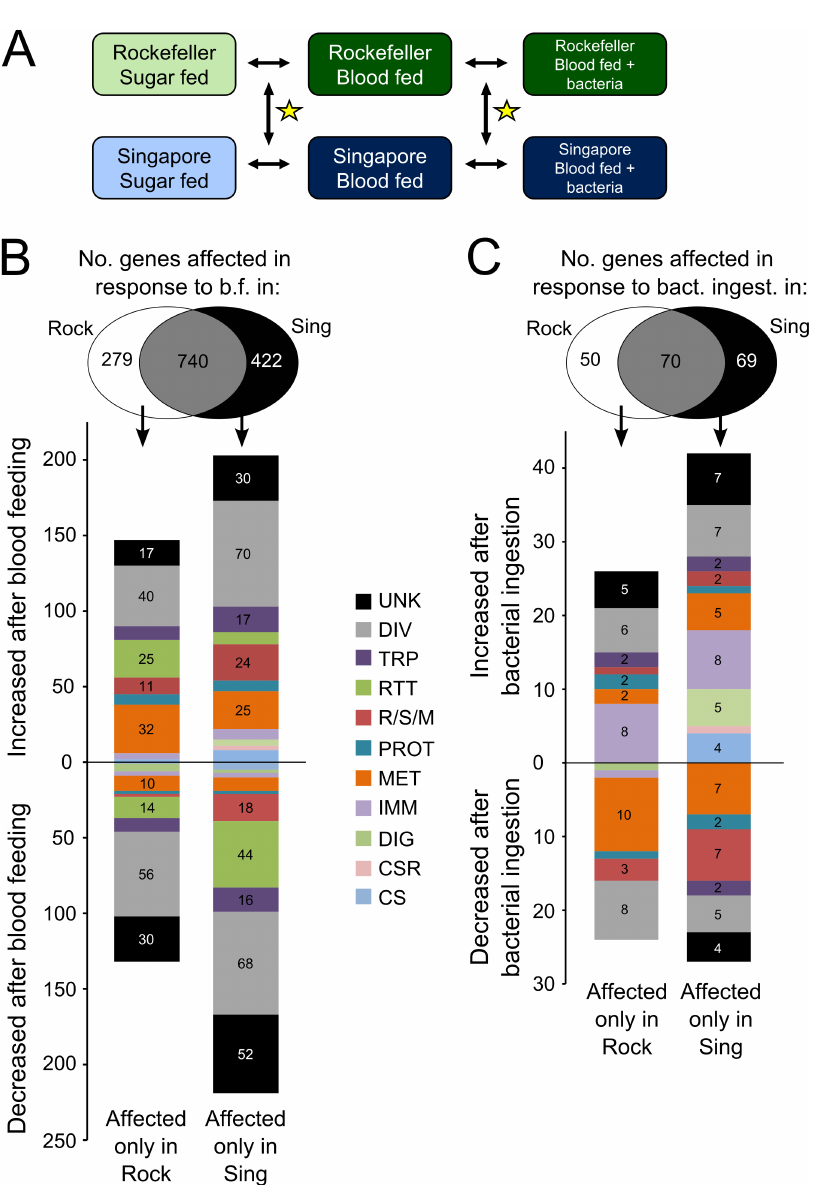
Fig 5. Genes showing significant changes in transcript abundance in response to blood feeding or bacterial re-introduction in either Rockefeller or Singapore female midguts. (A) Experimental design to measuregene expression differences between Rockefeller and Singapore female midguts. Rockefeller and Singaporefemales were reared in paralleland providedwith 3% sucrose + antibiotics (pen/ strep + gent) upon eclosion.At 5–7 days post eclosion,females were maintained on sucrose, given a sterile blood meal, or given a blood meal spiked with a mixed culture of seven common mosquitomidgut bacteria(S2 Table). Midguts were dissected from each strain/feeding treatment 12 hours post blood feedingand genome wide gene expressionwas measuredfor each strain/feeding treatment relative to a pooledreference sample using custom Agilent gene expressionmicroarrays. Comparisons of interest in this experiment (indicated by black arrows) are as follows: Rock sucrose vs. Rock blood fed, Sing sucrose vs. Sing bloodfed, Rock blood fed vs. Rock bacteria fed, Sing blood fed vs. Sing bacteriafed. We were also interested in how responseto treatment differed betweenthe strains (yellowstars), i . e . transcript changesobservedin one strain that are smaller or absent in the other strain. (B) Strain-specific changes in transcript abundance in response to blood feeding. Changein transcript abundancein responseto blood feeding( i . e . sucrose fed vs. blood fed) was measuredfor both Rockefeller and Singaporefemales. Genes that responded to treatment in either or both strain(s) are shown in the Venn diagram. Genes that increasedor decreased in transcript abundance in only Rockefelleror only Singapore( i . e . strain-specific responses) are shown in the bar graphsalong with